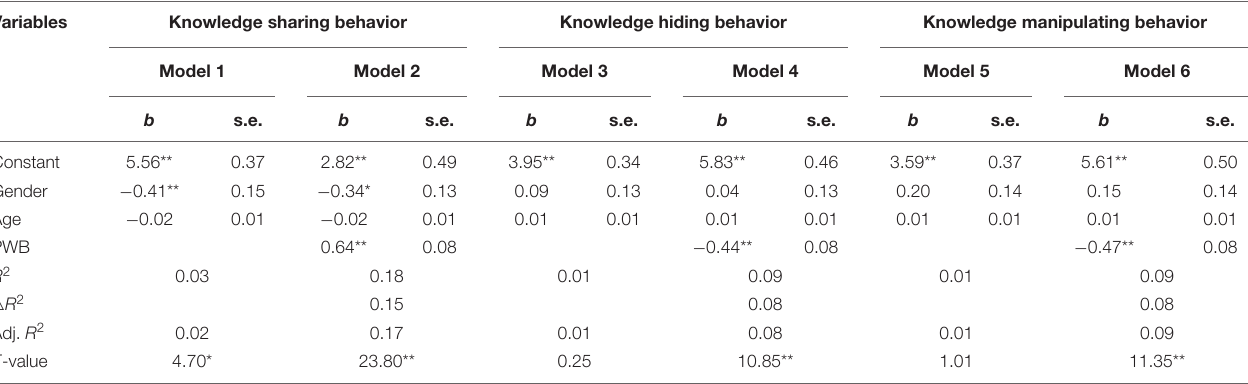
TABLE 2 | Results of hierarchical linear regression analysis for hypothesis 1, 2, and 3.